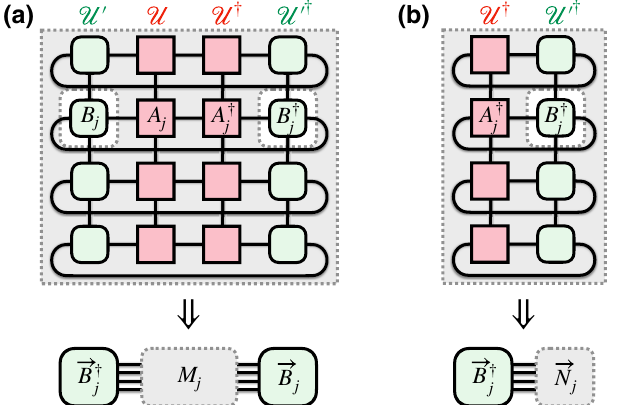
FIG. 4. The schematic diagram for the minimization of Eq. (13). (a) Tensor M j is the environment of (cid:7) B j and (cid:7) B † in Tr[ U (cid:2) UU † U (cid:2) † ]. (b) Tensor (cid:7) N j is the environment of (cid:7) B † Tr[ U † U (cid:2) †